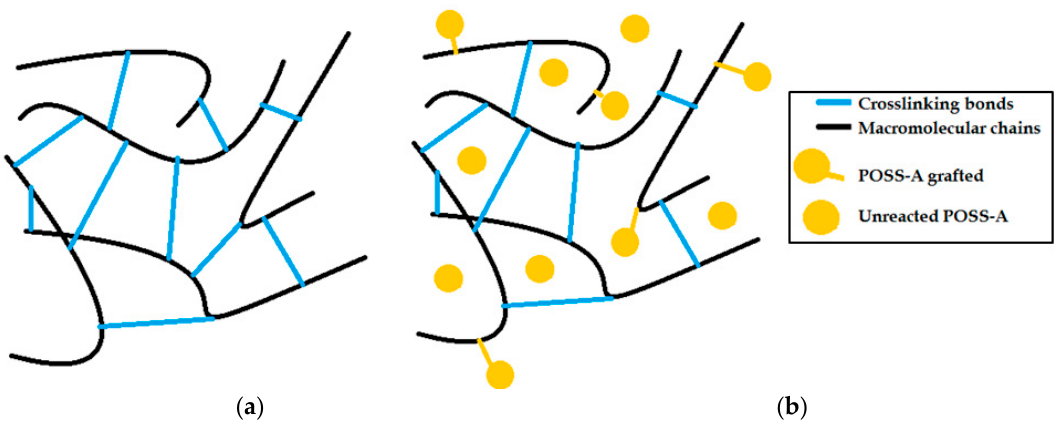
Scheme 2. Schema of the crosslinked rubber: ( a ) without fillers and ( b ) with POSS ‐ A as pendant